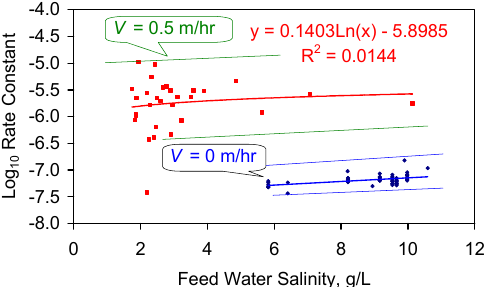
Figure C6. Rate constant vs. feed water salinity at fluid velocities of 0 m/h (Type A Catalyst. ST Trial Group Series) and 0.5 m/h (Type B Catalyst. E146/7 Trial series). The E146/7 Trial series (operated at